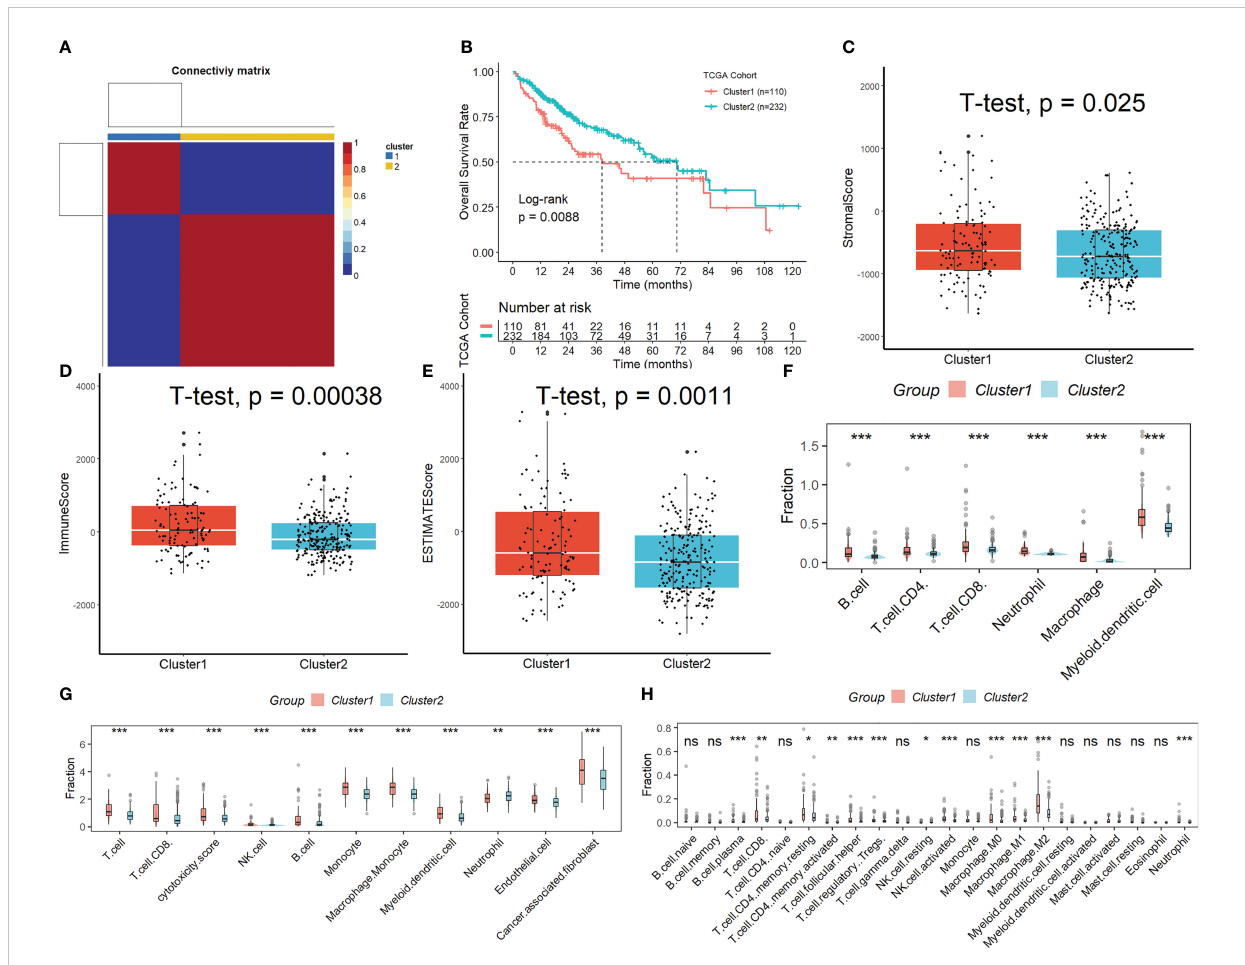
FIGURE 2 Subtypes identi fi cation by NMF algorithm based on NKs marker genes. (A) Samples were split into two subclasses. (B) Signi fi cant disparities in patient survival existed between the two subgroups. (C-E) Difference of immunological, stromal, and ESTIMATE scores in different molecular subtypes. The difference in the percentage of immune cell in fi ltration in different molecular subtypes was analyzed by the TIMER (F) , MCPcounter (G) , and CIBISORT (H) . ns, not signi fi cant; *p < 0.05; **p <0.01; ***p <